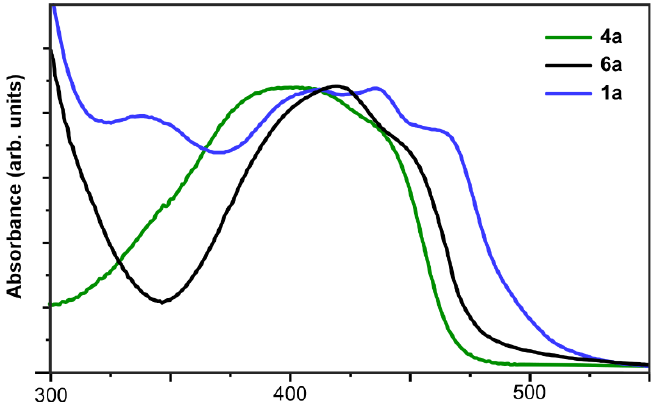
Figure 11. Solid state UV-vis spectra of DTP species 4a and 6a compared to the PBTz oligomer 1a